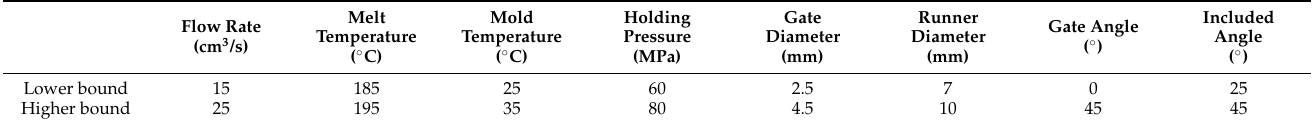
Table 2. Levels of parameters required for performing simulation analyses.